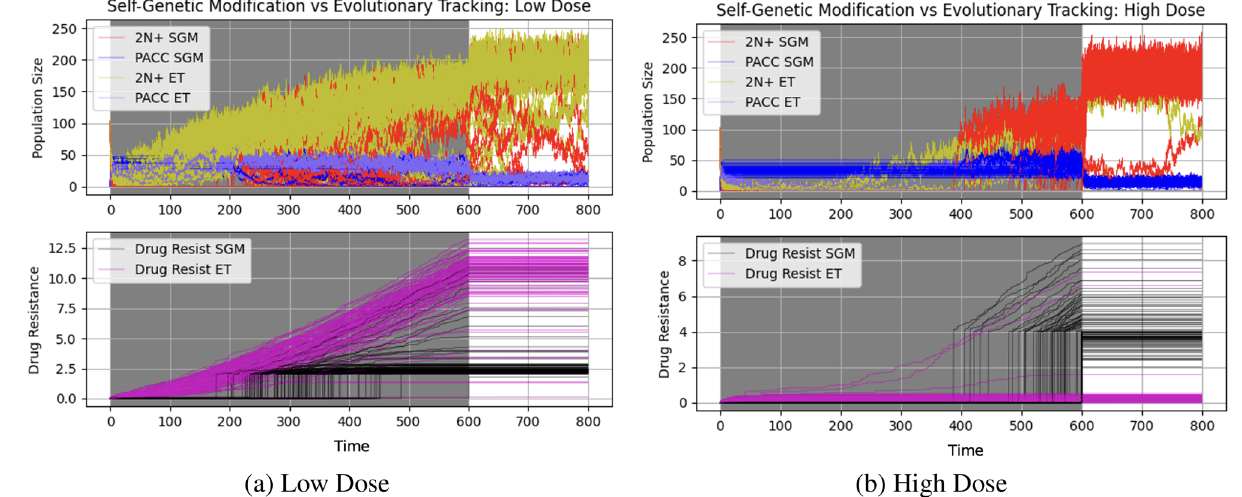
Figure 6. Competitive dynamics of cancer populations with self-genetic modification and evolutionary triage under continuous therapy. Under low dose therapy ( a ), cell population under ET outcompete those under SGM in the majority of cases. Conversely, under high dose therapy ( b ), cell populations under SGM outcompete those under